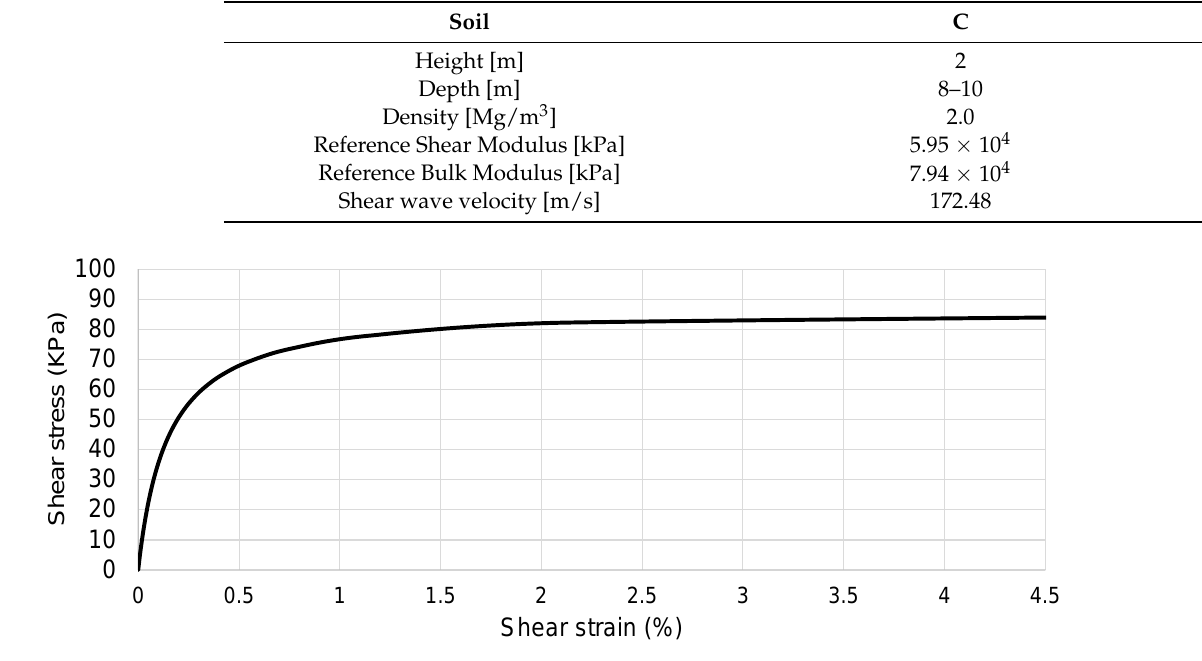
Figure 5. Soil C backbone curve. Table 3. Soils C characteristics.